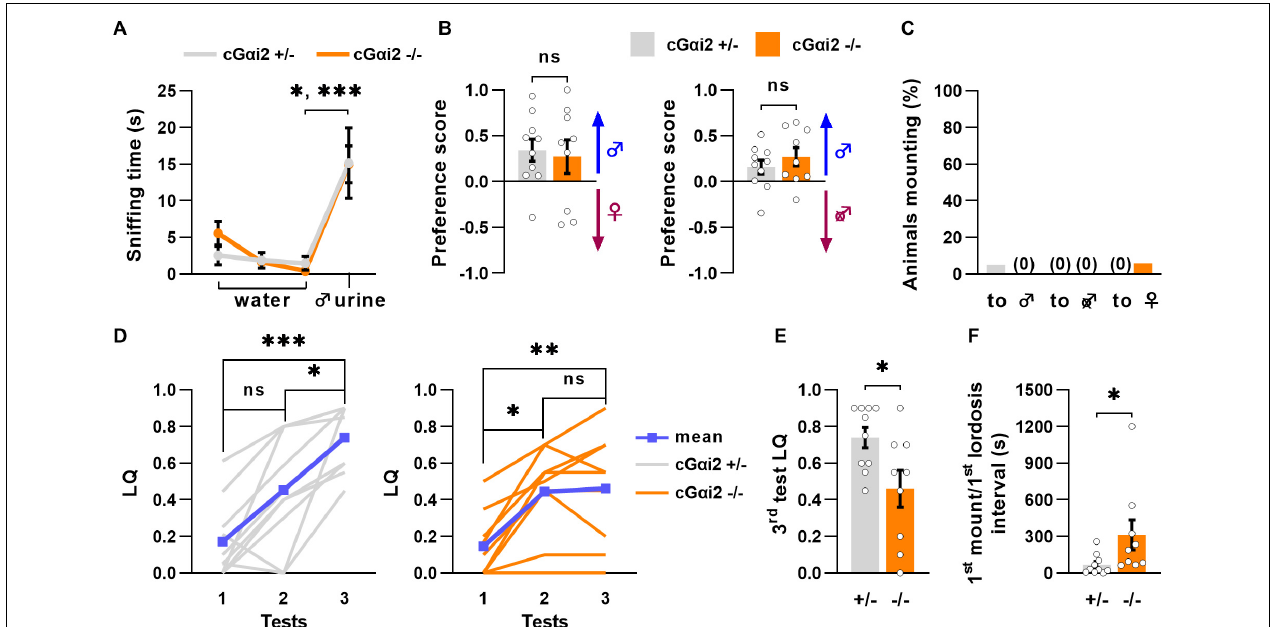
FIGURE 3 | Incomplete sexual receptivity in G α i2 mutant females. (A) cG α i2 + / − ( N = 10) and cG α i2 − / − ( N = 9) are able to detect intact male urine in the habituation—dishabituation paradigm (Kruskal-Wallis: P < 0.001, Dunn’s multiple comparison tests: water 3 vs. urine 1 cG α i2 + / − P < 0.05, cG α i2 − / − P < 0.001). (B) Olfactory preference of social cues in cG α i2 + / − ( N = 10) and cG α i2 − / − ( N = 9) female mice in a two-choice test. Females had the choice between male urine vs. estrus female ( left ) or castrated male ( right ) urine. cG α i2 + / − and cG α i2 − / − animals show a preference for male urine in both tests and no differences